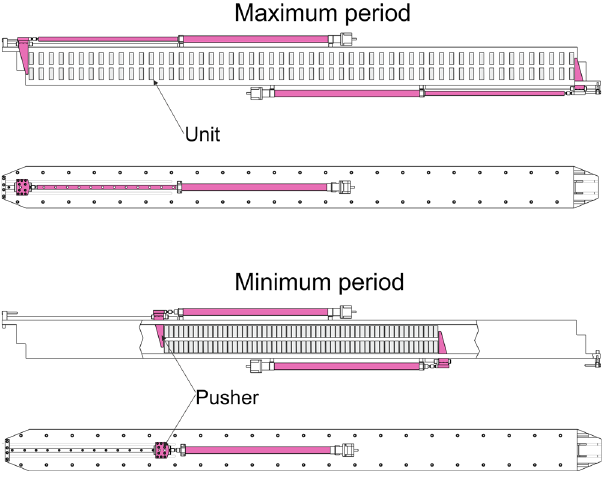
20. Undulator mechanical design side and top